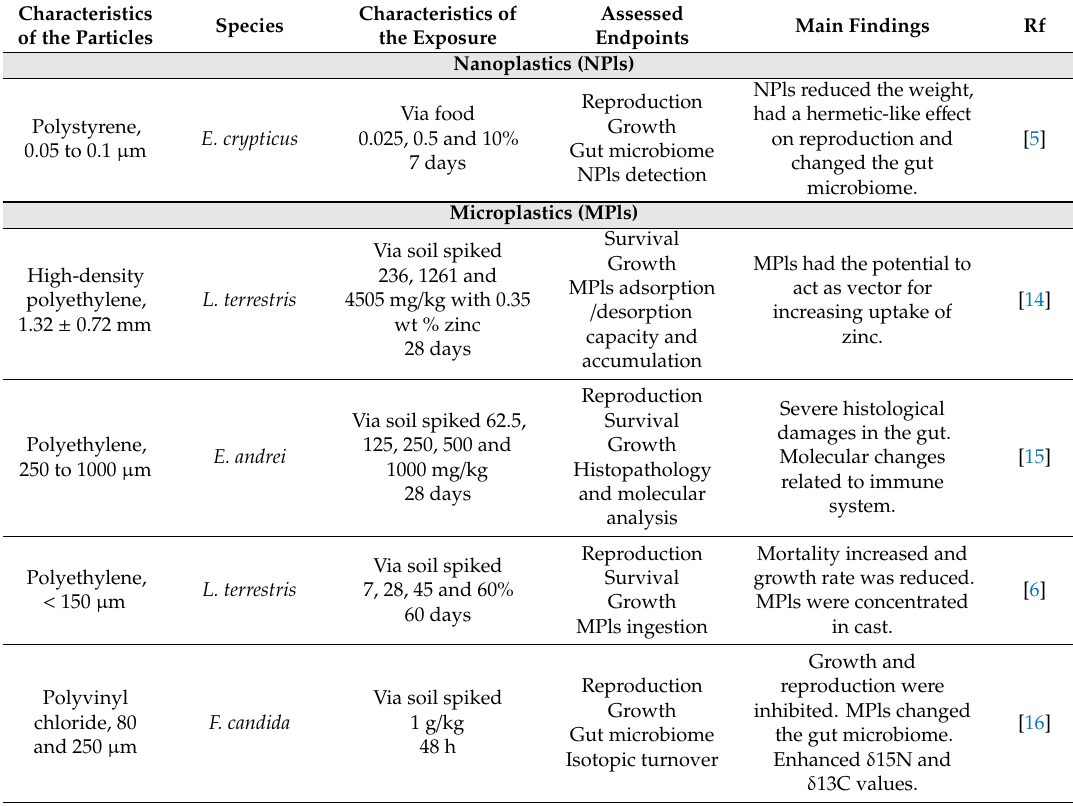
Table 1. Studies assessing the e ff ects of microplastics and nanoplastics on soil invertebrates. Characteristics of Assessed Characteristics Main Findings Rf Species the Exposure Endpoints of the Particles Nanoplastics (NPls) NPls reduced the weight, had a hermetic-like e ff ect on reproduction and changed the gut